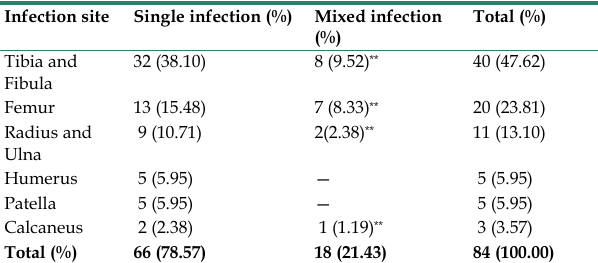
Table 2. The Distribution and percentage of affected